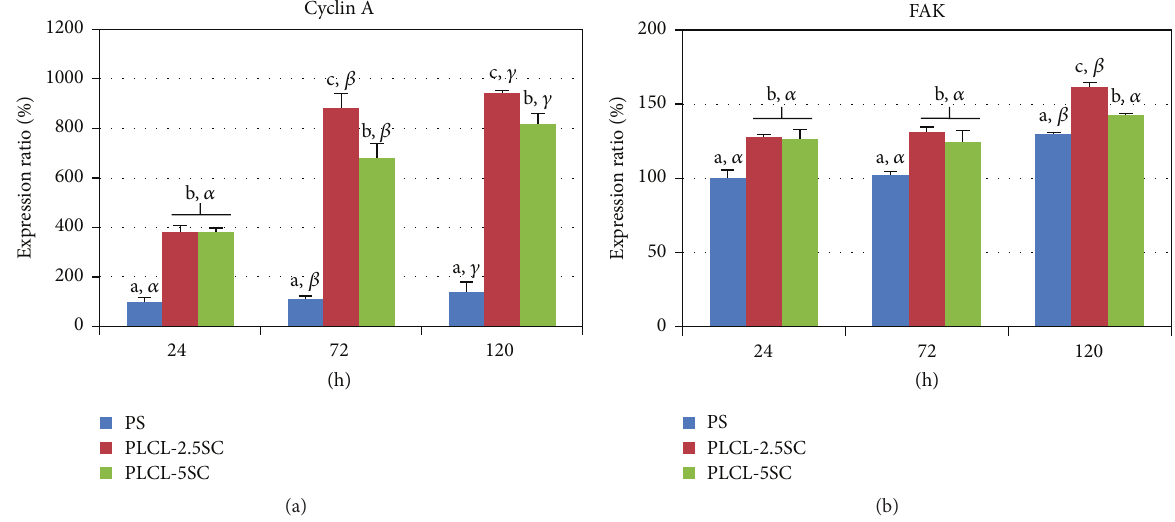
Figure 12: Percentages of (a) cyclin A and (b) FAK relative expression of BCP-K1 on PLCL-2.5SC and PLCL-5SC membranes examined by ELISA compared to the PS surface at 24 hours. All data are mean ± SD. Statistical difference is indicated by lowercase letters (a, b, and c) for each membrane on the same day. The symbols 𝛼 , 𝛽 , and 𝛾 indicated the difference between each day of the same membrane ( 𝑝 ≤ 0.05